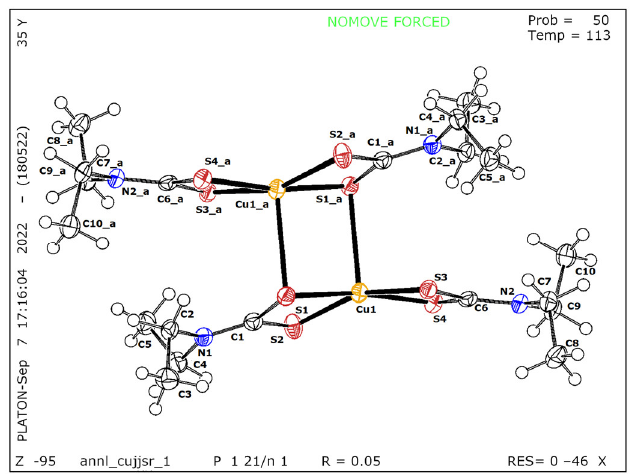
Figure 1. Comparison of 1 H-NMR of Na(DDTC) (red) and Cu(DDTC) 2 (blue).